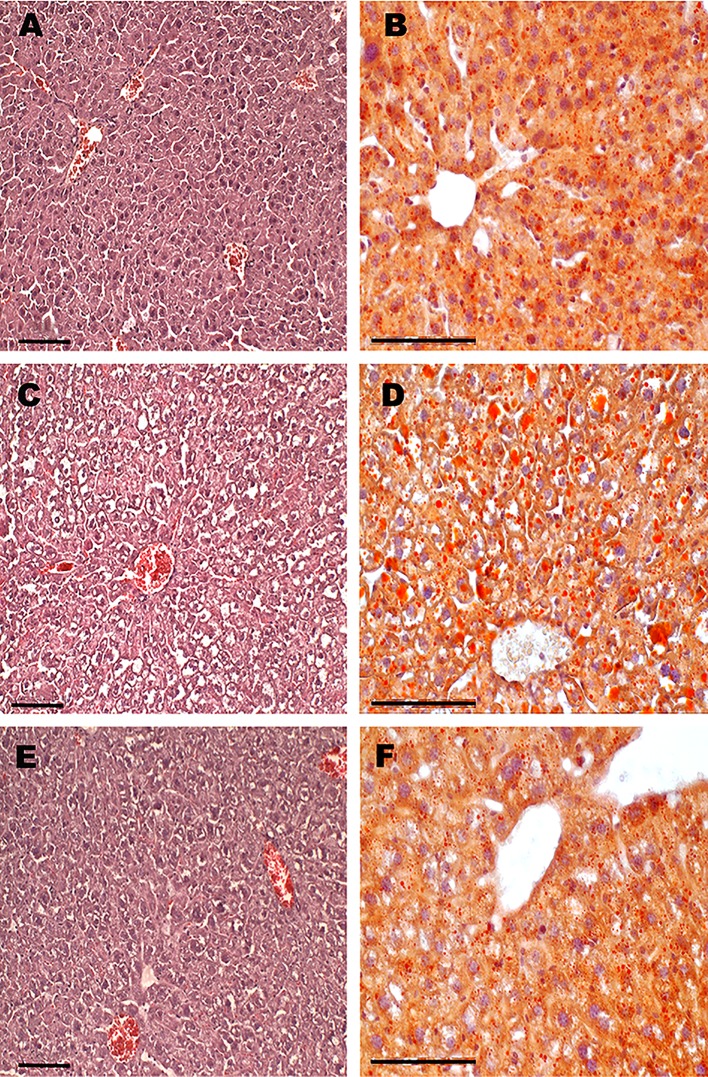
The histological evidence of steatosis in the liver of obese agouti-mice, and the improving effect of long-term metformin treatment (600 mg/kg/day).A, B–Group a/a (control); C, D–Group Ay/a; E, F–Group Ay/a-M600. The liver histology was evaluated using the staining of liver sections with hematoxylin and eosin (A, C, E), while the hepatic lipid deposition was evaluated by the Sudan III-staining (B, D, F). The orange inclusions and granules after the Sudan III staining are the lipid and lipoproteins accumulations located within hepatocytes. The liver sections from animals of each of the three studied groups were mounted on the same glass. Scale bars, 100 μm.